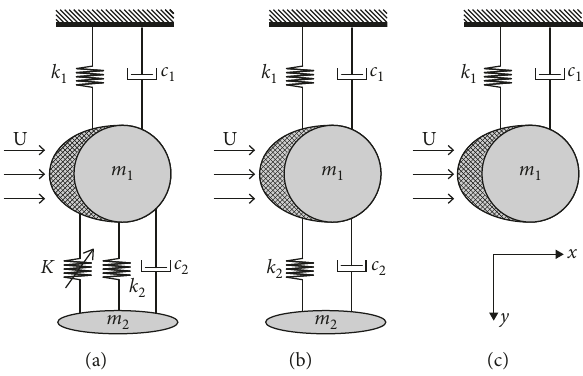
Figure 1: Simplified model of iced conductors (a) with TTMD system, (b) with TMD system, and (c) without added